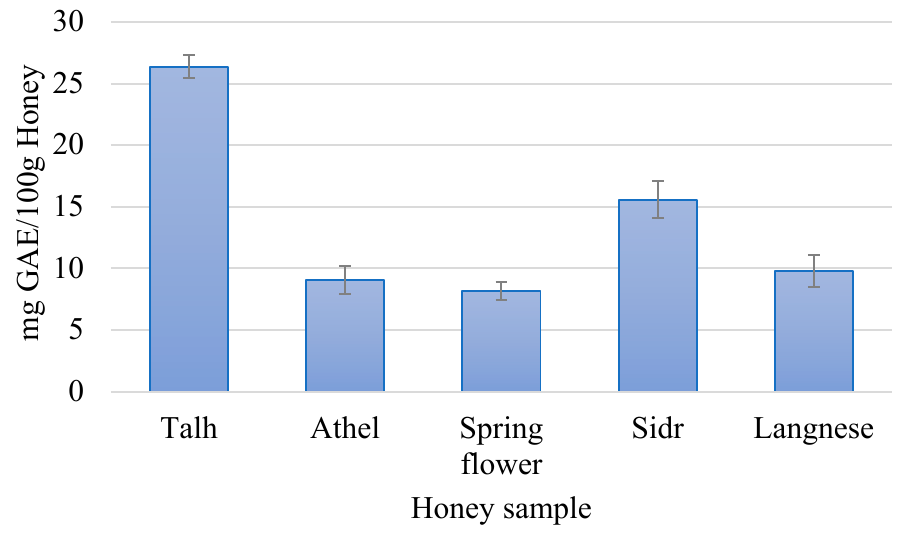
Figure 2. Total phenolic contents (TPC) assay of honey samples.